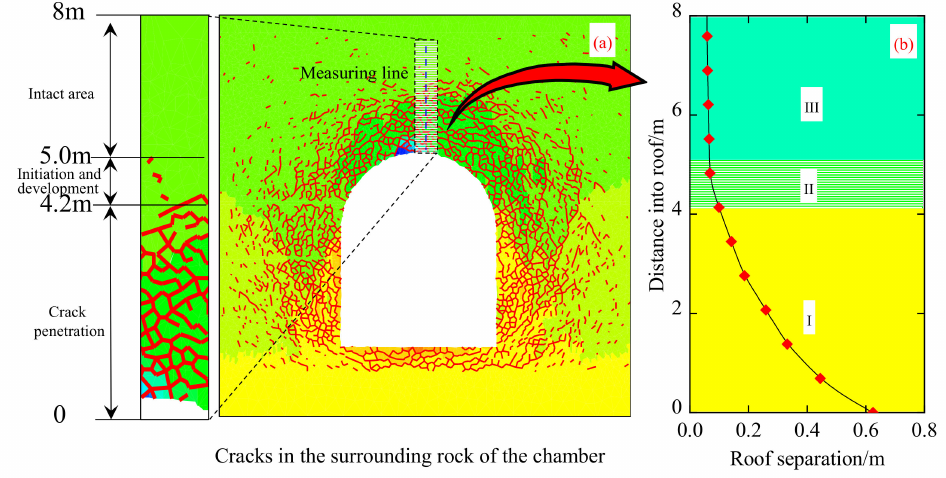
Figure 12. Deformation and damage law of the chamber